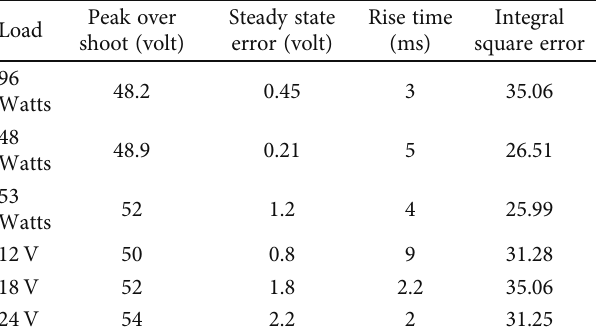
Table 2: Comparison of the time domain